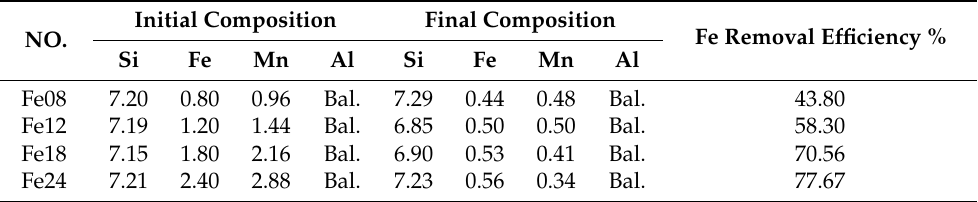
Table 1. The chemical composition and Fe removal efficiency of the alloys. Initial Composition Final Composition NO.